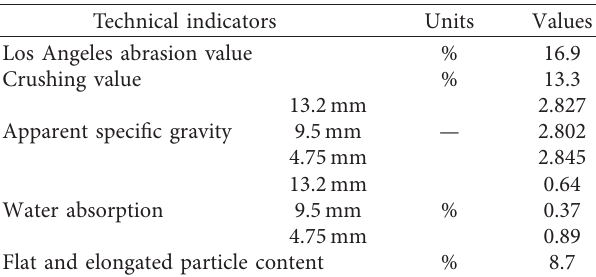
Table 3: Technical indicators of coarse aggregate in this paper.